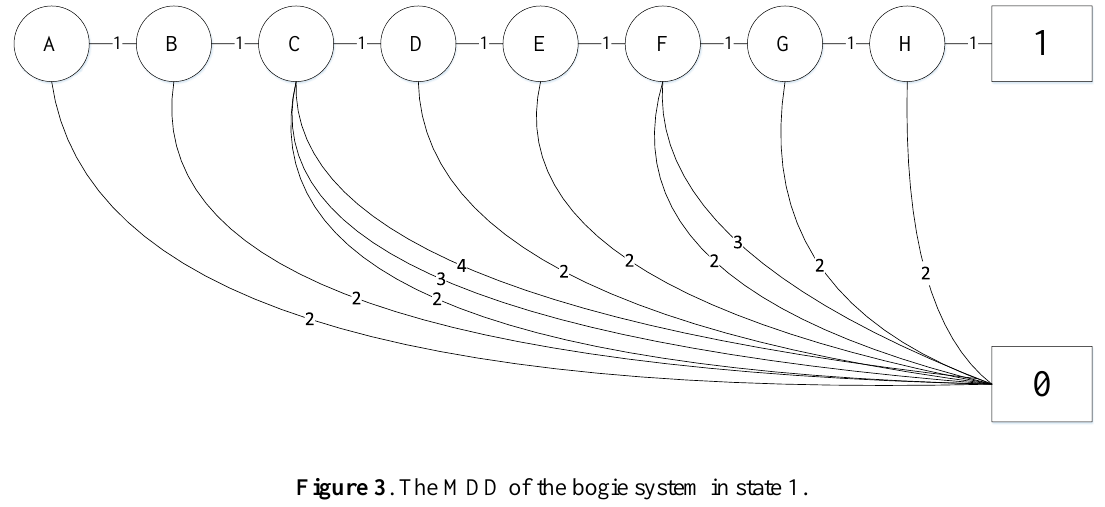
Figure 3 . The MDD of the bogie system in state 1.